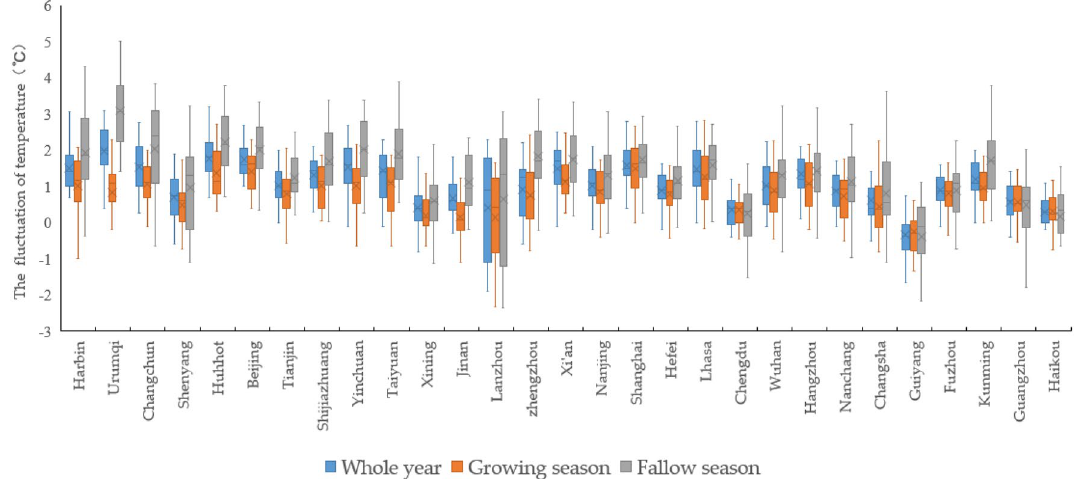
Figure 2. The temperature rises in China’s major provincial capitals from 1991 to 2018.